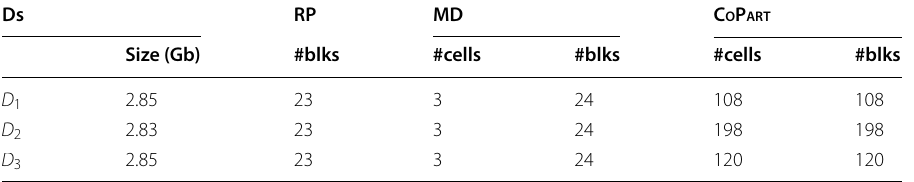
Table 2 Partitioning